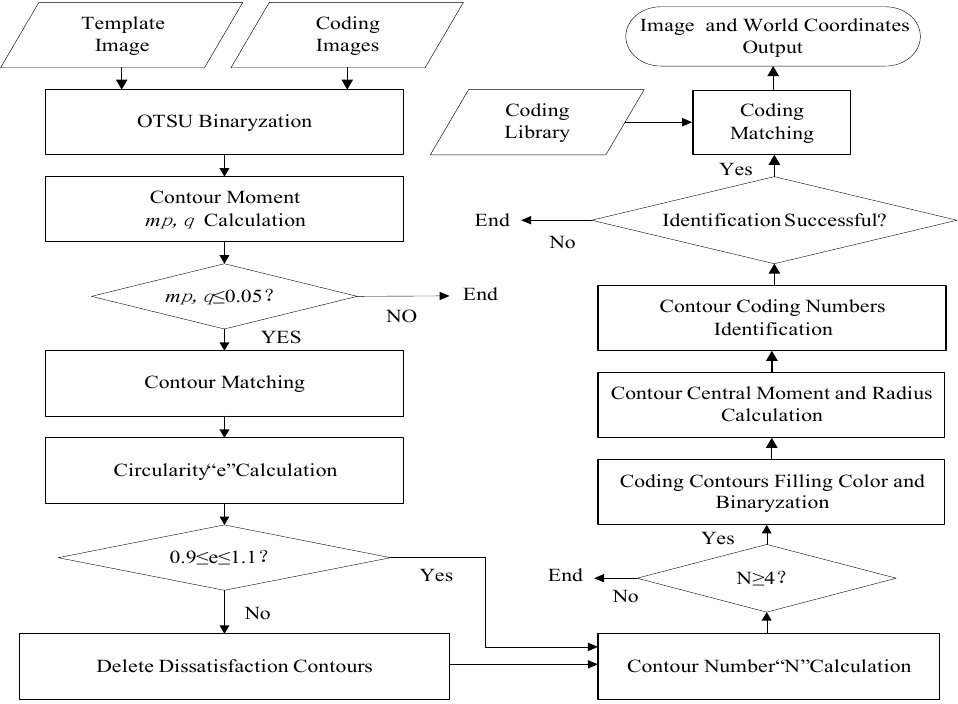
Figure 3. Flowchart of coding graphics identification and